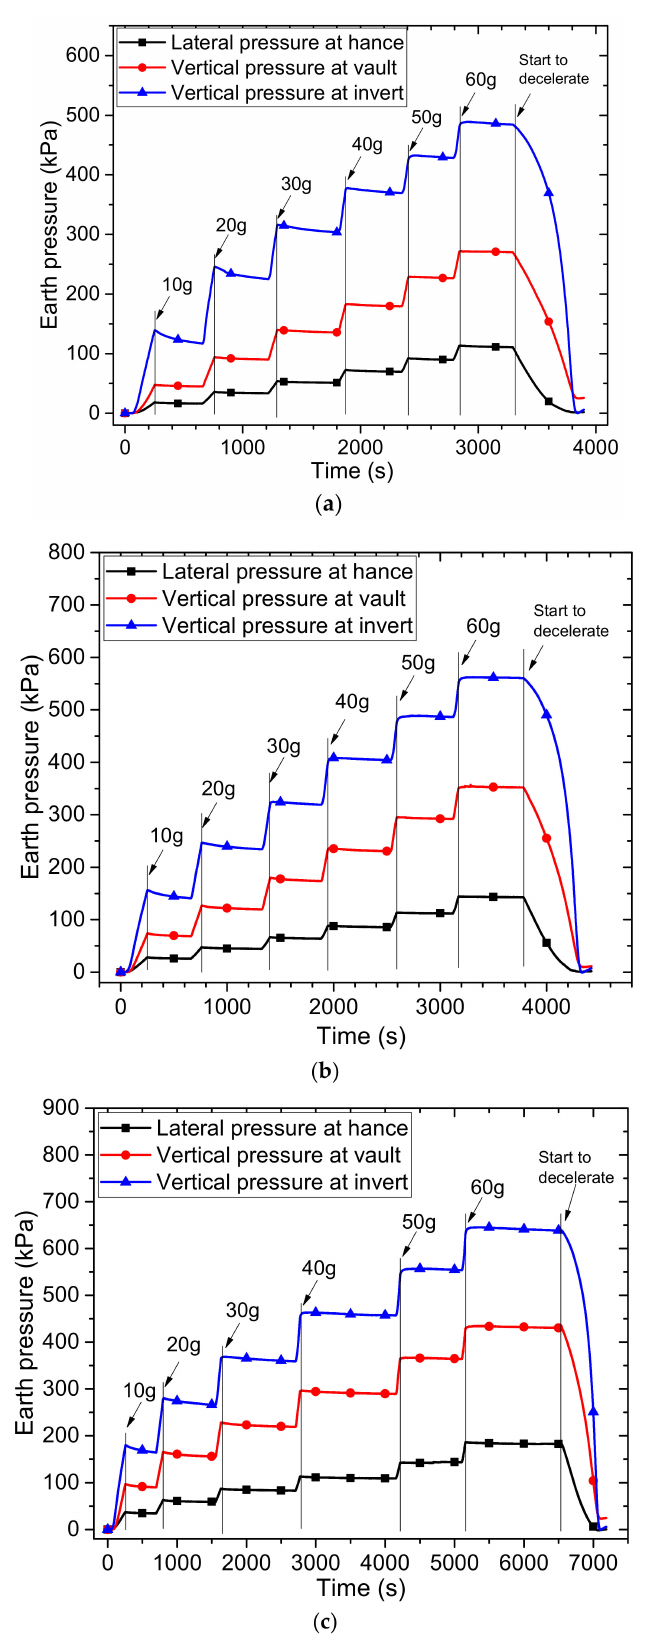
Figure 9. Variations of earth pressures versus test time: ( a ) 1.0 D, ( b ) 1.5 D, ( c ) 2.0